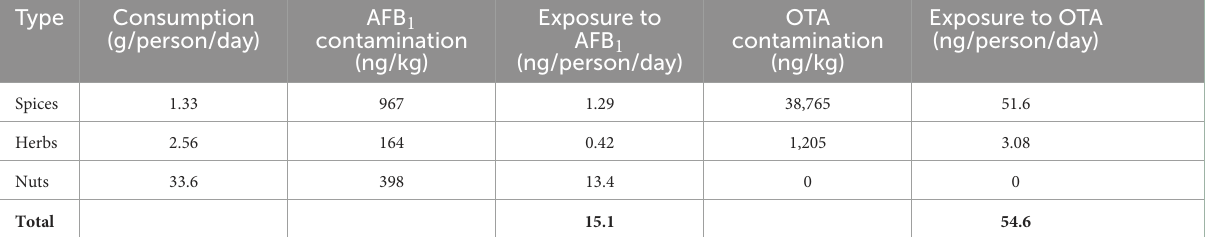
TABLE 7 Average consumption of spices, herbs, and nuts, average contamination of AFB 1 and OTA, and exposure level to AFB 1 and OTA.